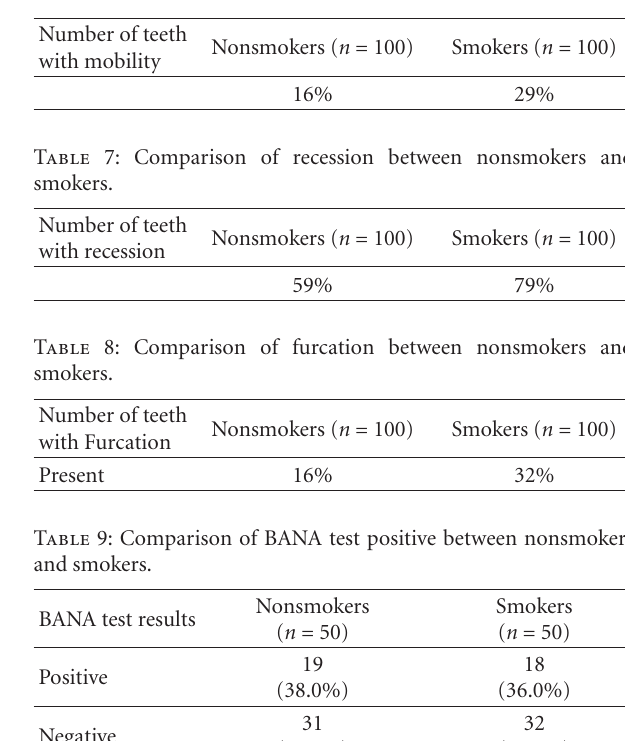
Table 3: Comparison of PI, GI, BI, and CI between nonsmokers and smokers. Results are presented in Mean ± SD (min-max).